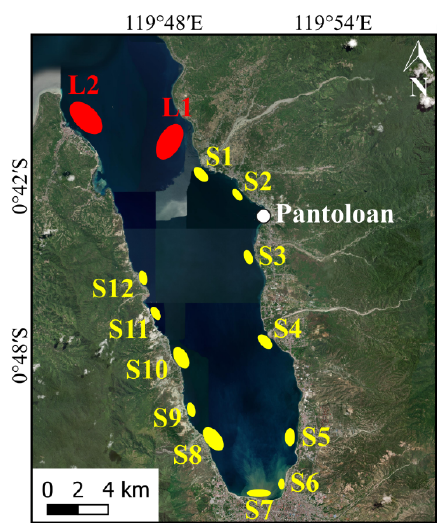
Figure 6. Location of the hypothesized landslides (S: small; L: large) in Palu Bay (background ESRI).